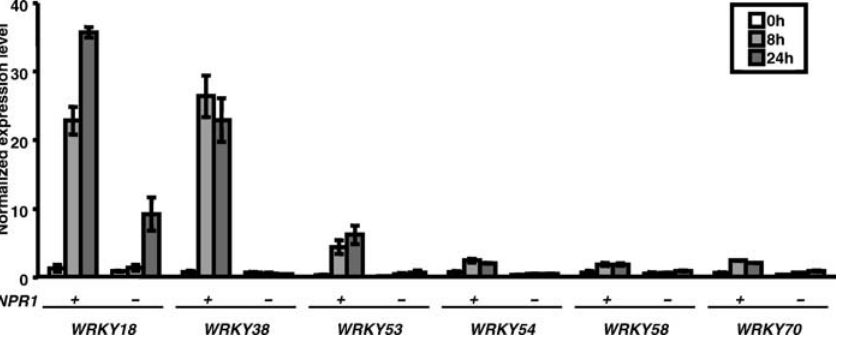
Figure 2. Induction of WRKY Genes by SAR Inducers and NPR1 Plotted here are log 2 -transformed microarray data normalized by the GeneSpring package, showing the expression levels of six WRKY genes 0, 8, and 24 h after BTH treatment in WT ( NPR1 þ ) and npr1 mutant ( NPR1 (cid:1) ). The expression levels of WRKY59 and WRKY66 were too low to be detected under these